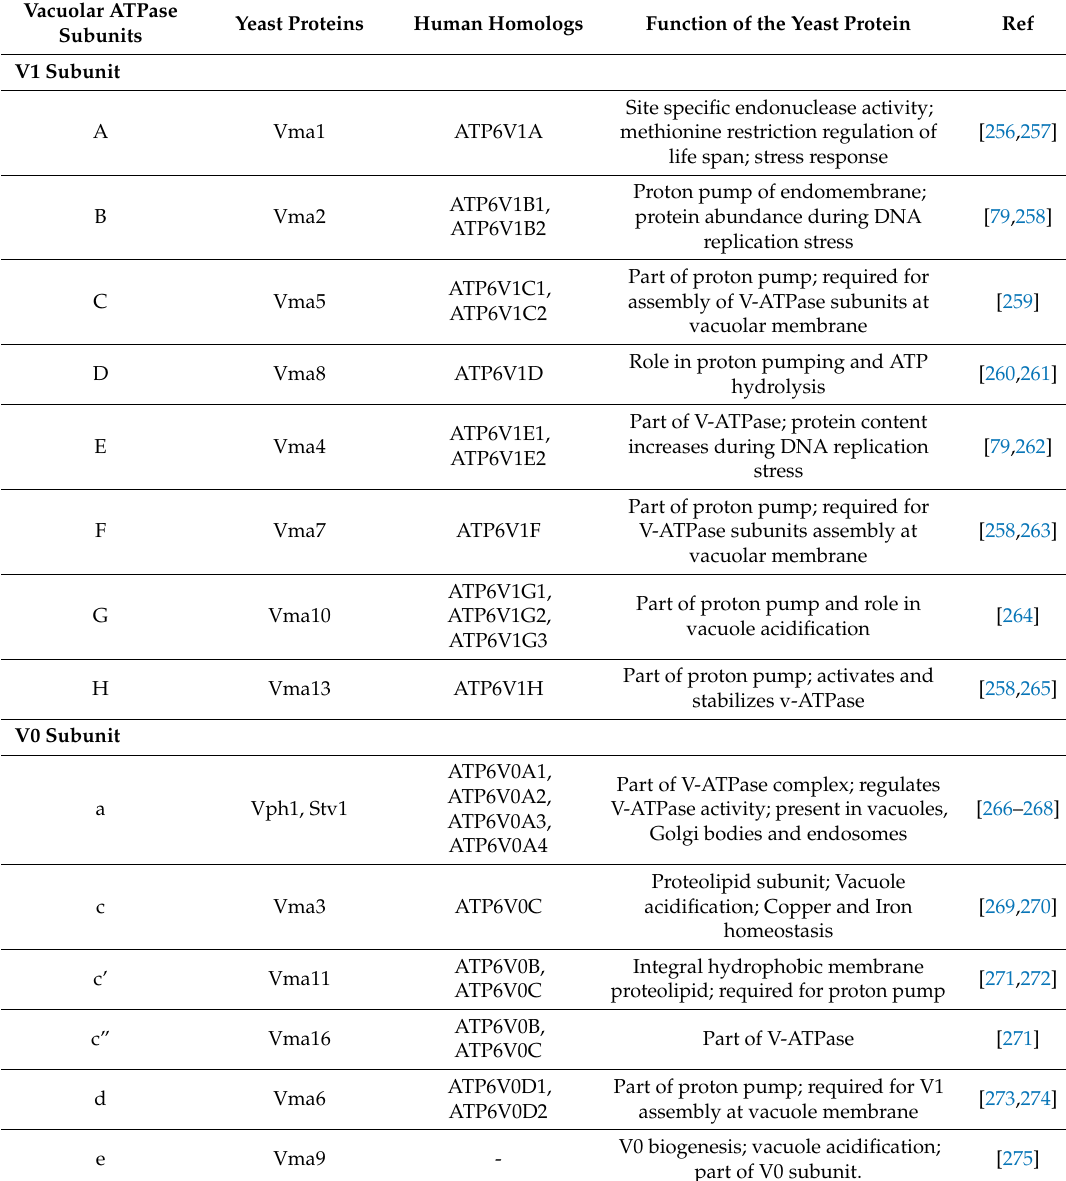
Table 6. Proteins of the V-ATPase proton pump conserved from yeast to humans and their function in